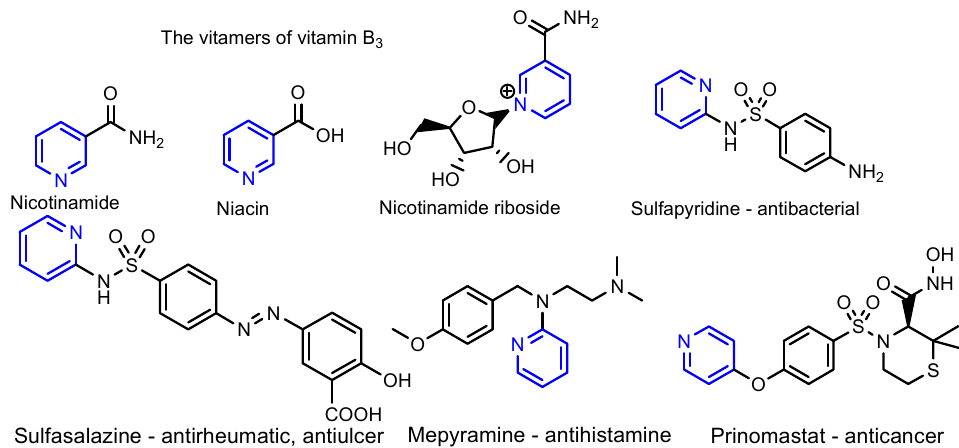
Figure 1. Drugs containing the pyridine nucleus.